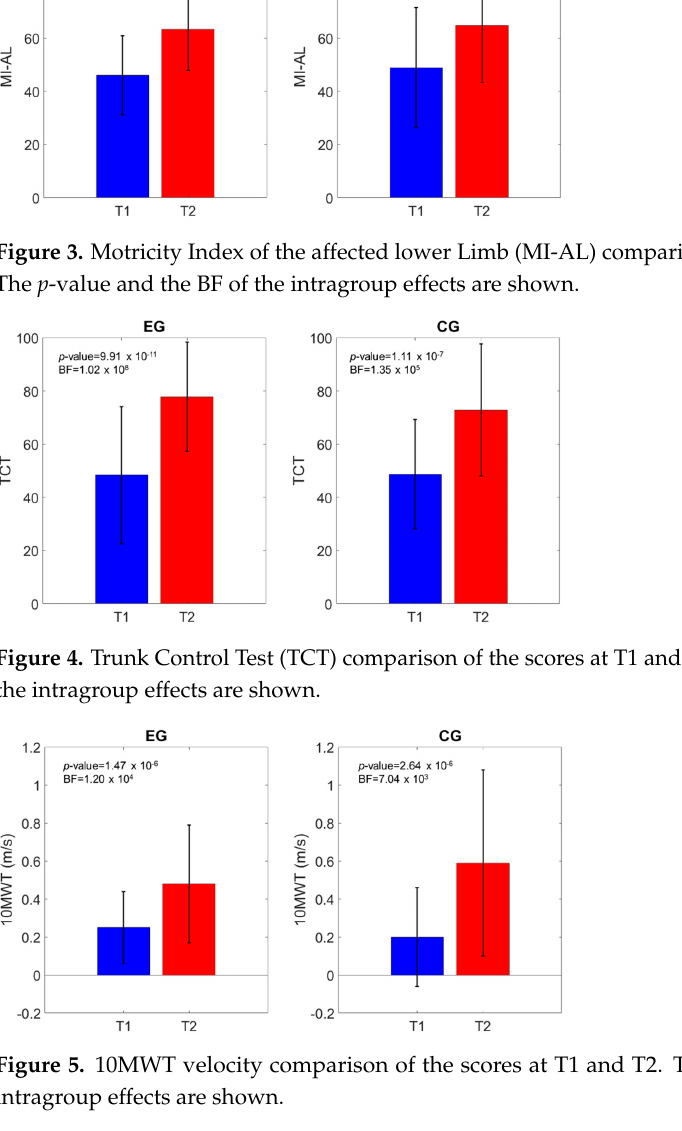
Figure 6. Modified Barthel Index (mBI) comparison of the scores at T1 and T2. The p -value and the BF of the intragroup effects are shown.